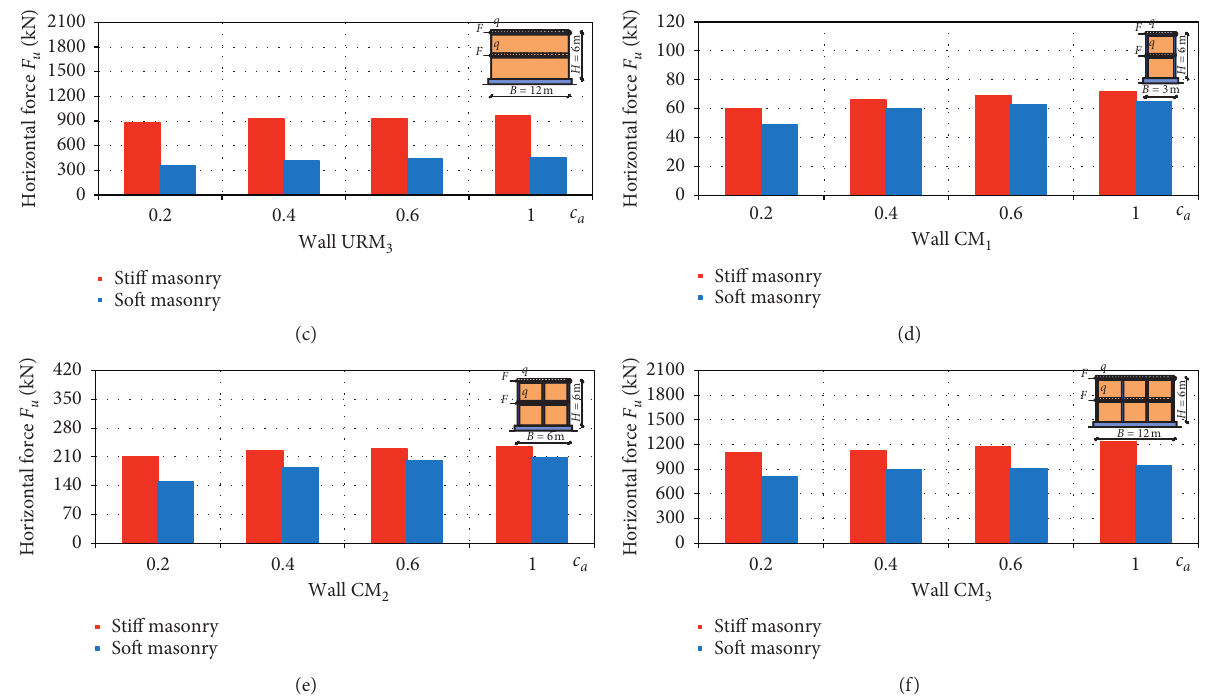
Figure 11: Relation between limit force F u and coefficient of anisotropy c a . (a) URM 1 ; (b) Wall URM 2 . (c) Wall URM 3 . (d) Wall CM 1 . (e) Wall CM 2 . (f) Wall CM 3